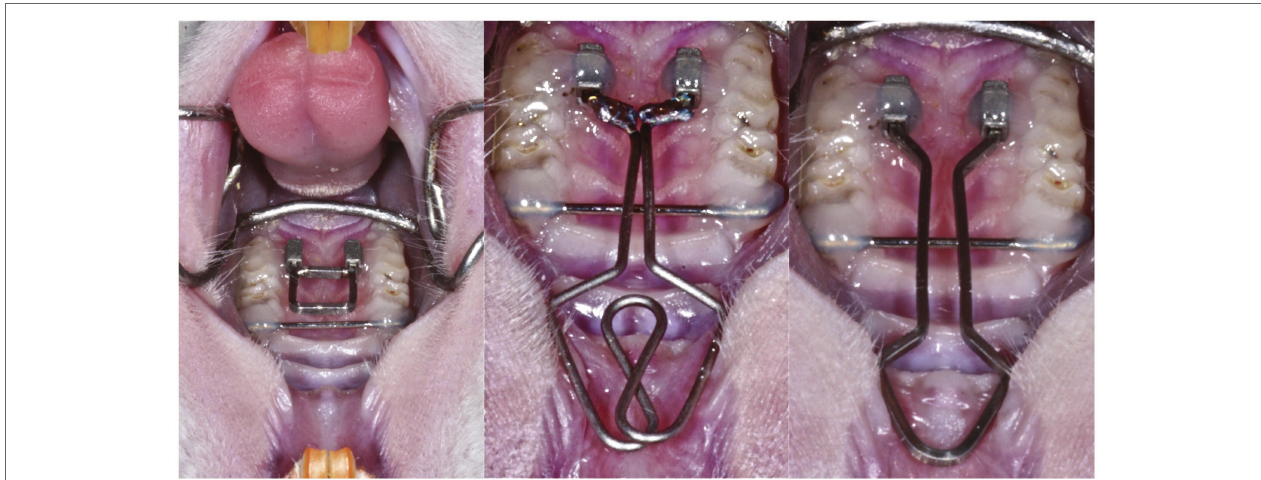
FIGURE 1 | In this animal model, expansion forces were applied on the second and third molars: a low force (middle) and a conventional force (right). The cheek retractor (left) provided access for microscopic view on the operation field during the appliance placement. The transverse position of the first molars was stabilized with a transpalatal bar. Then, a guide was used to standardize the placement of the attachments for appliance insertion. The low-force spring was a 0.016 " diameter round beta-titanium wire welded on 0.016 " /0.022 " ends. For the conventional force spring, a beta-titanium 0.016 " /0.022 " wire was used. The ends of the spring were fixated with composite in the